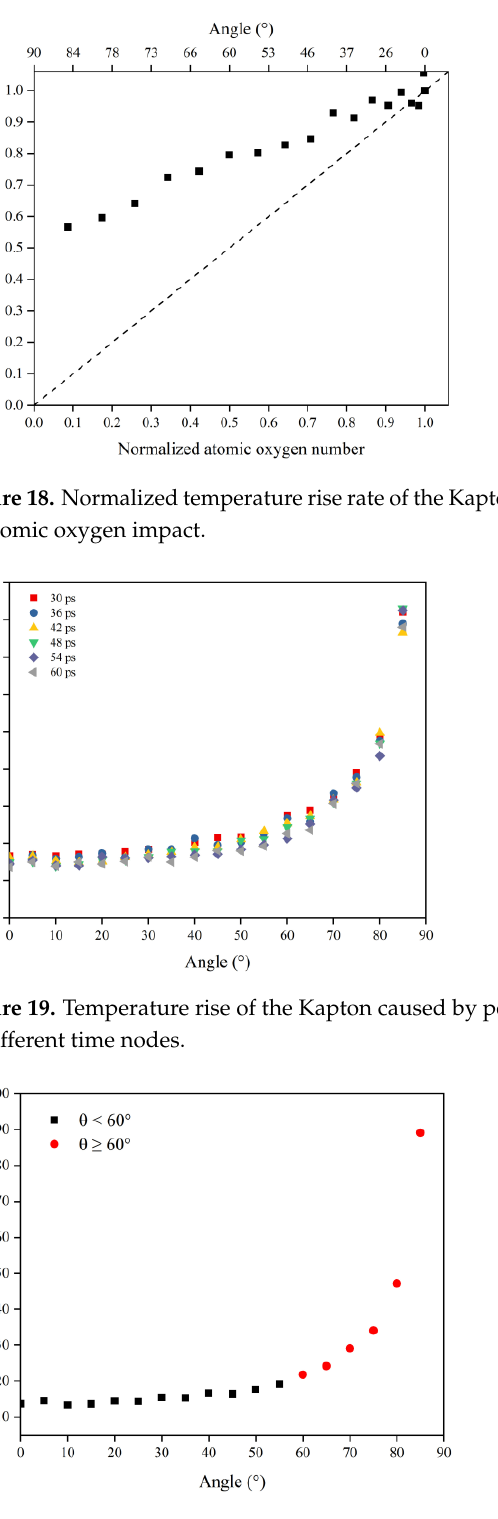
Figure 20. Temperature rise rate of the Kapton caused by atomic oxygen at different incident angles.